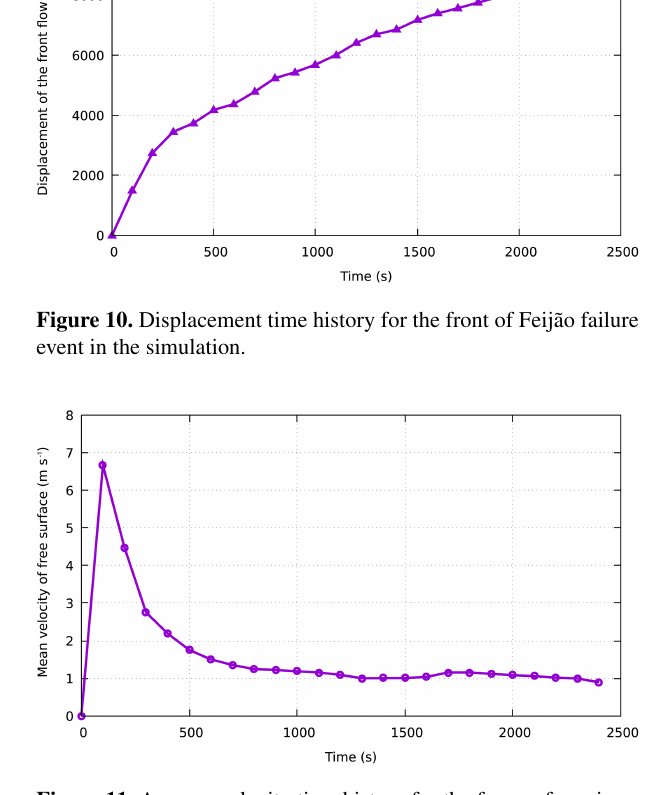
Figure 11. Average velocity time history for the free surface simu- lated of the Feijão failure event.